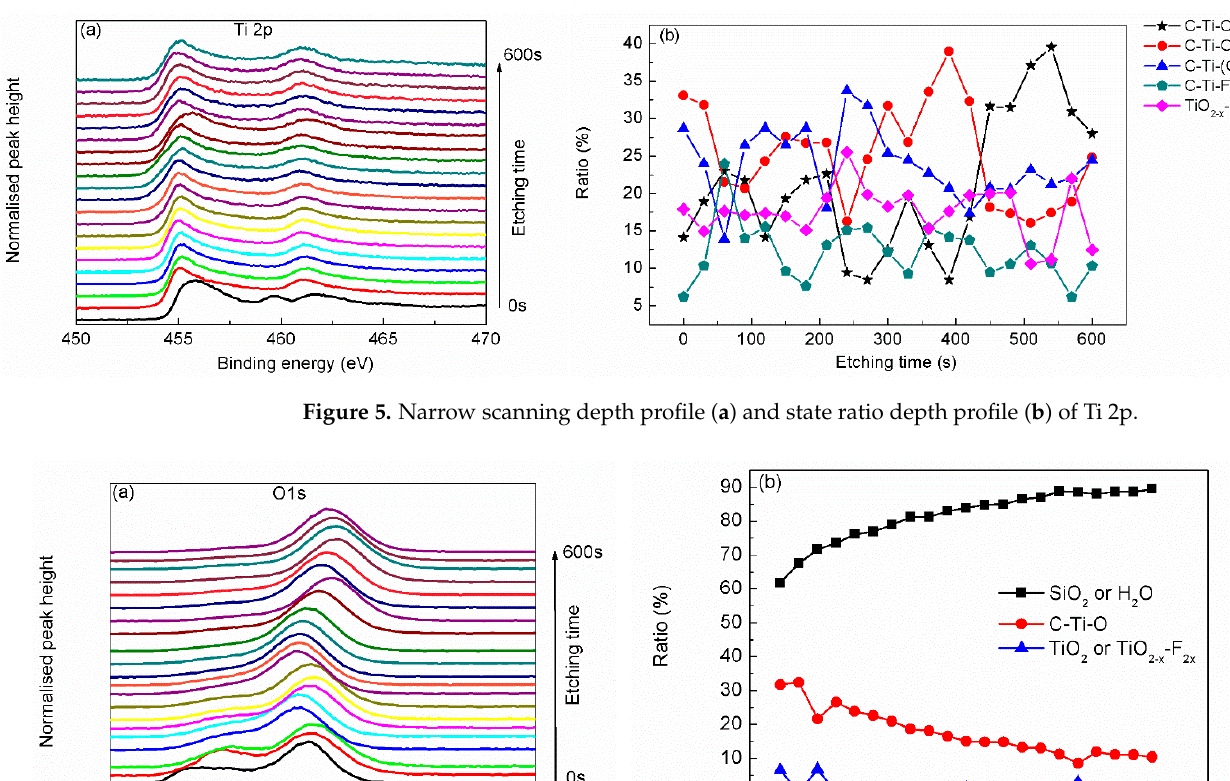
tribution related to C–Ti–C bond. It can be concluded that these O or F atoms bonded with